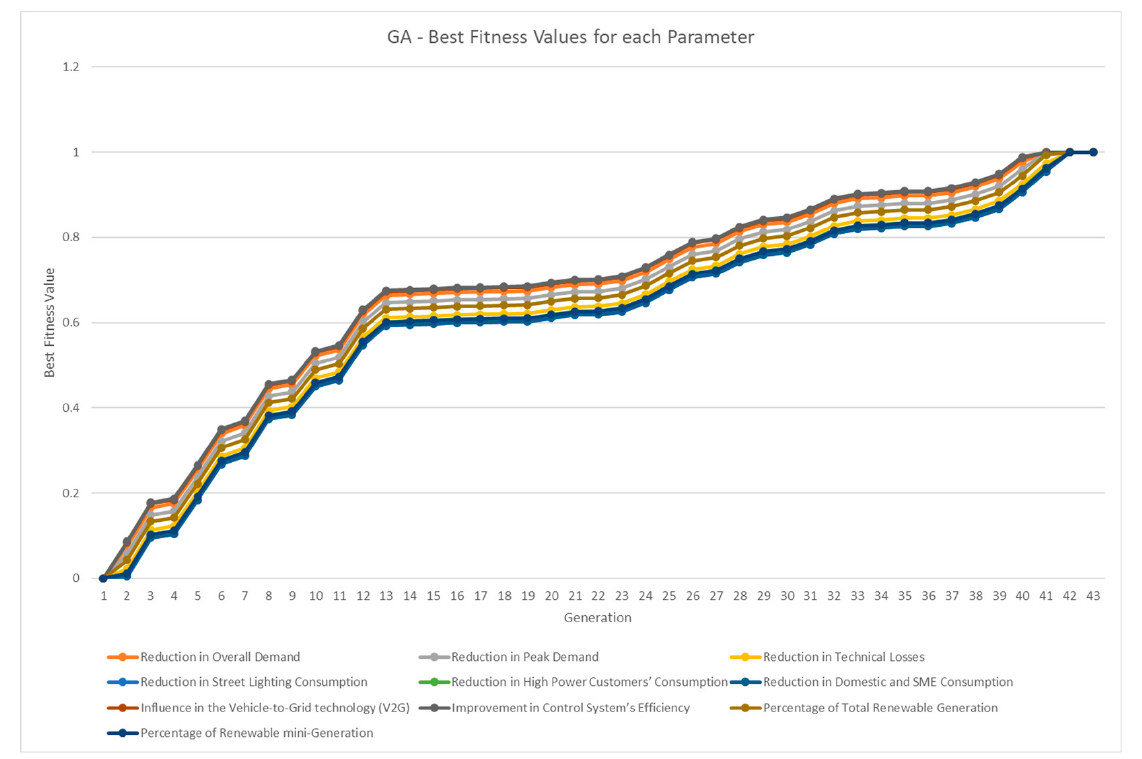
Figure 8. Average best fi tness value per generation or iteration.